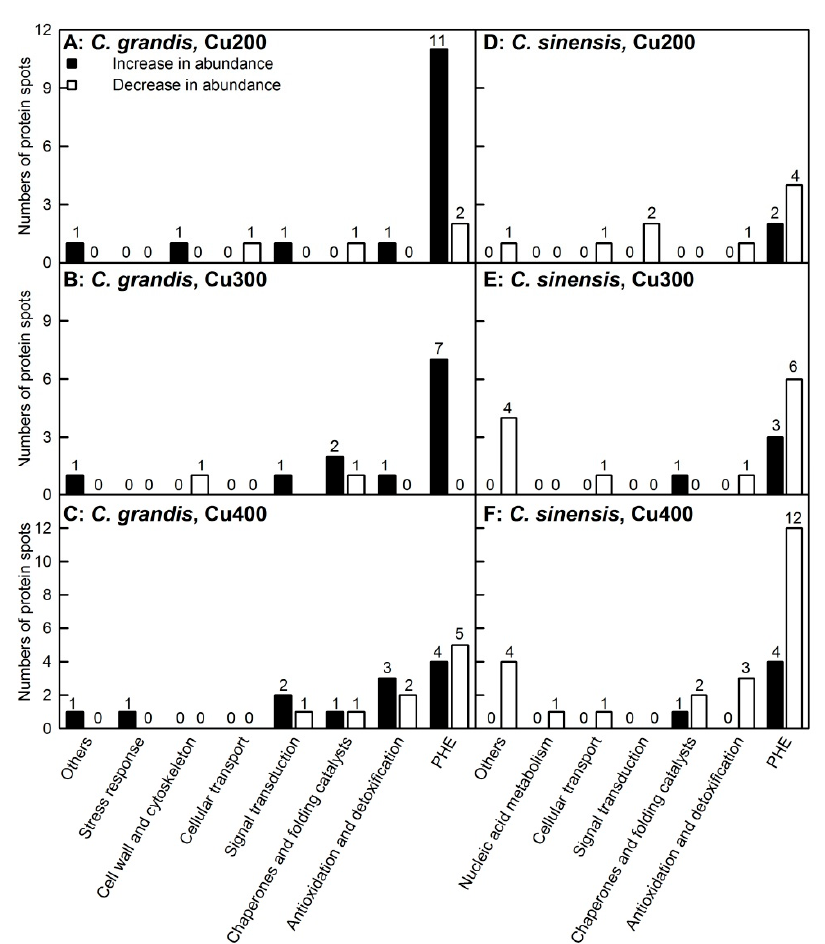
ff erentially abundant proteins (DAPs) in 200, 300 and 400 µ M Cu-treated Citrus Figure 3. Differentially abundant proteins (DAPs) in 200, 300 and 400 μ M Cu-treated Citrus grandis Figure 3. Di